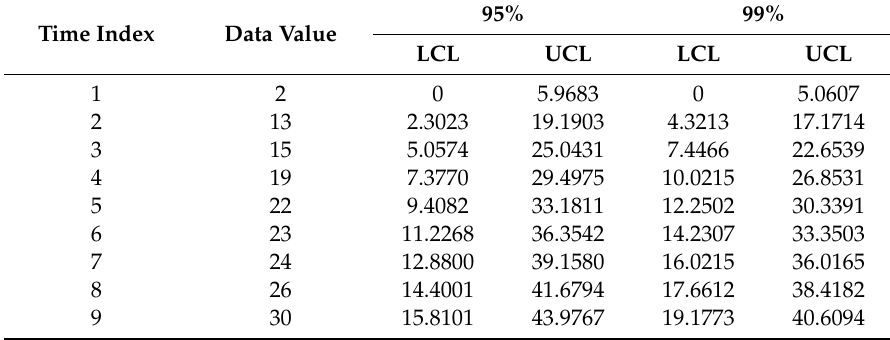
Figure 3. 3D plot for dataset #1 ( a ) MSE value, model number, NCD value; ( b ) R 2 value model number, NCD value. Table 5. Results of the 95% and 99% confidence intervals for the proposed model for dataset #1.